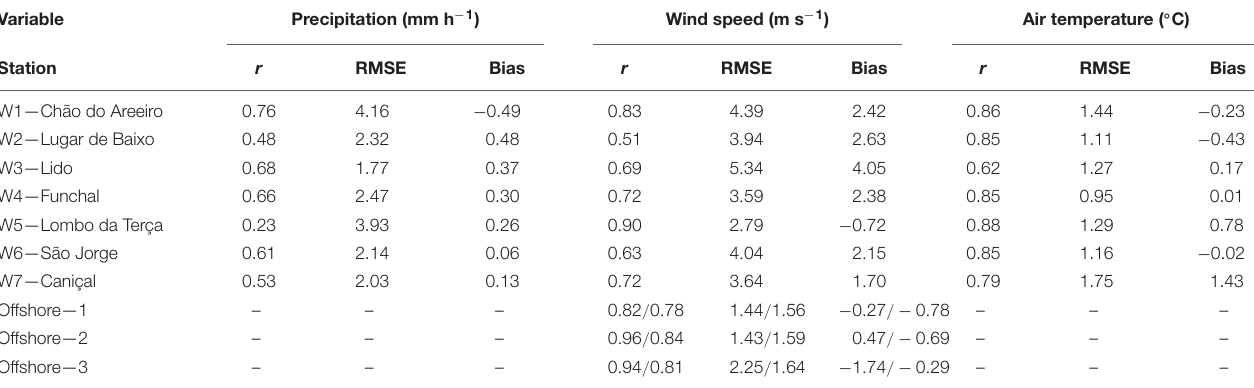
TABLE 2 | Statistics obtained from the comparison between hourly meteorological data (precipitation, wind speed, and air temperature), daily instantaneous satellite-derived winds (offshore stations), and model simulations between 1 and 28 February 2010.